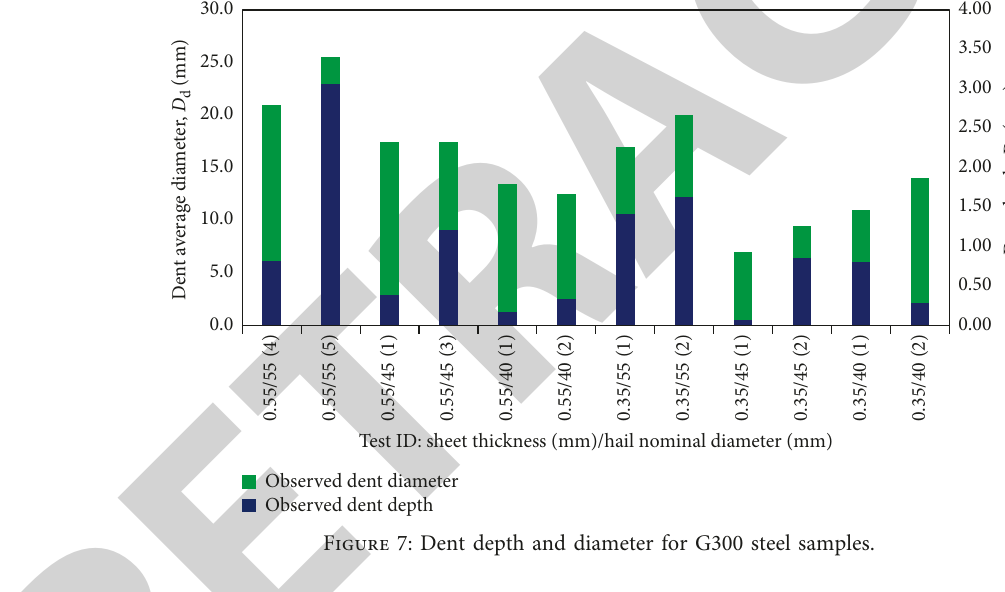
Figure 6: Dent depth and diameter for G550 steel samples.